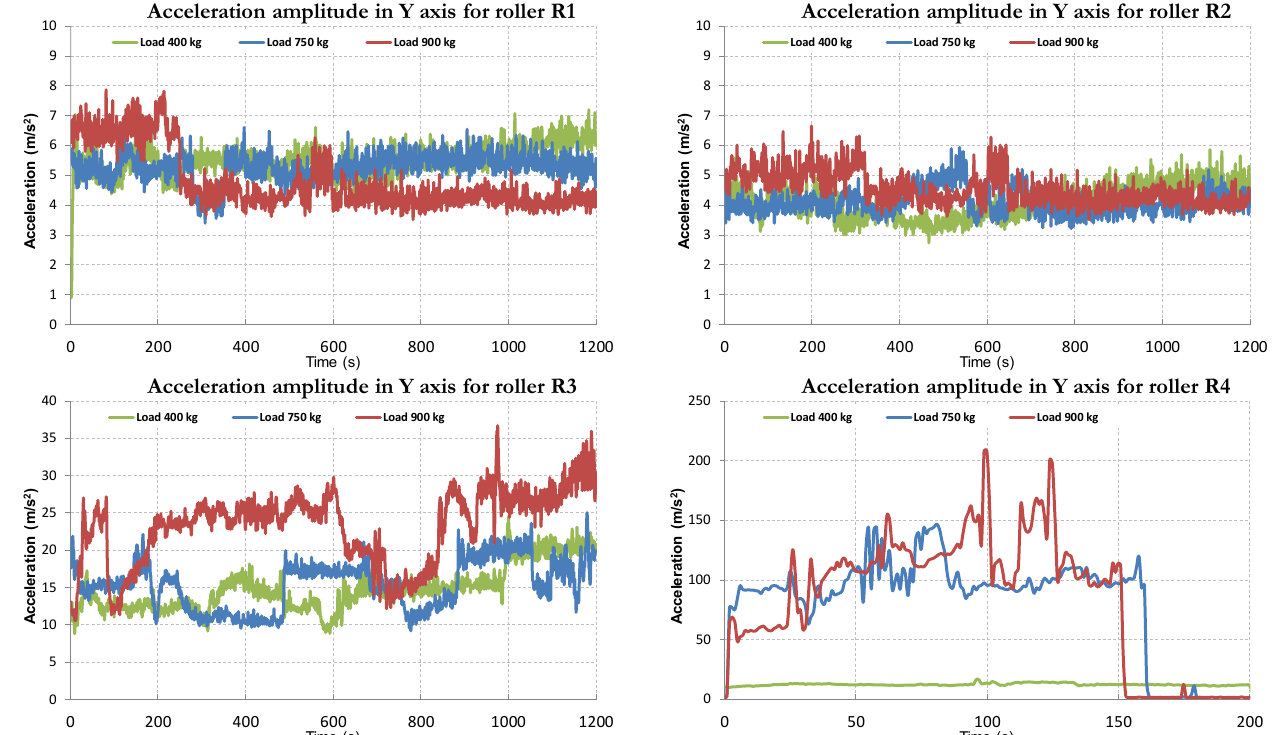
Figure 8. The value of the acceleration amplitude in the Y axis as a function of time, for loads of 400 kg, 750 kg and 900 kg with rollers R1, R2, R3 and R4.